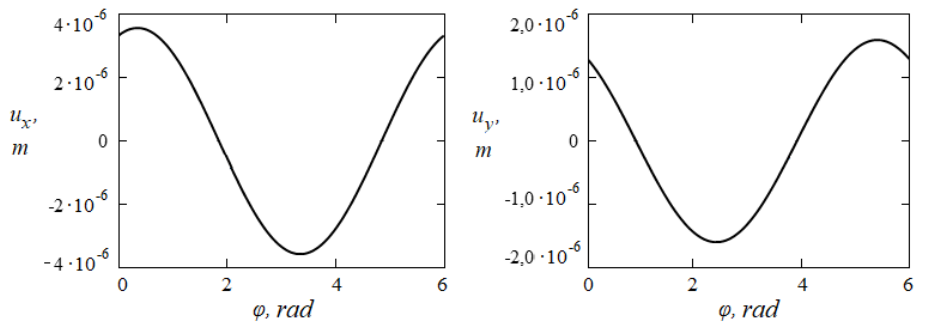
Fig. 7. Displacements defined on the boundary of the computational domain Ω. Finite element discretization of the computational domain sown in Figure 8.